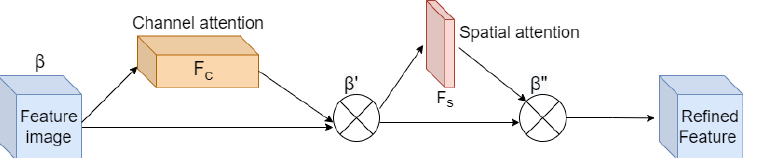
Figure 4. CBAM module (channel and spatial).